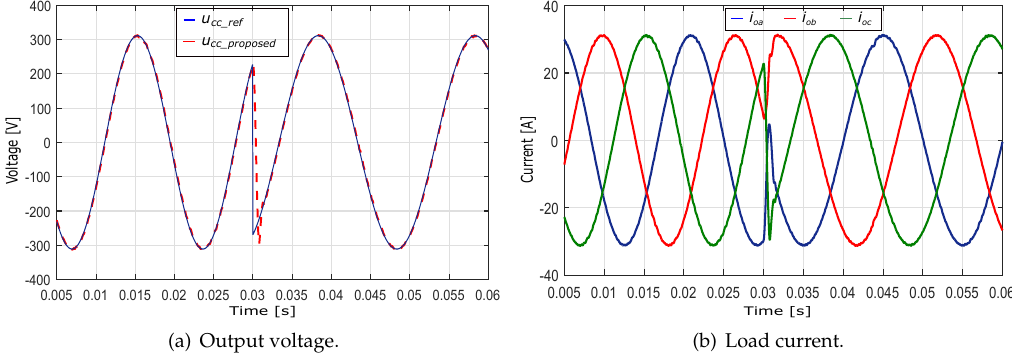
Figure 14. The output voltage and current responses under dynamic change in